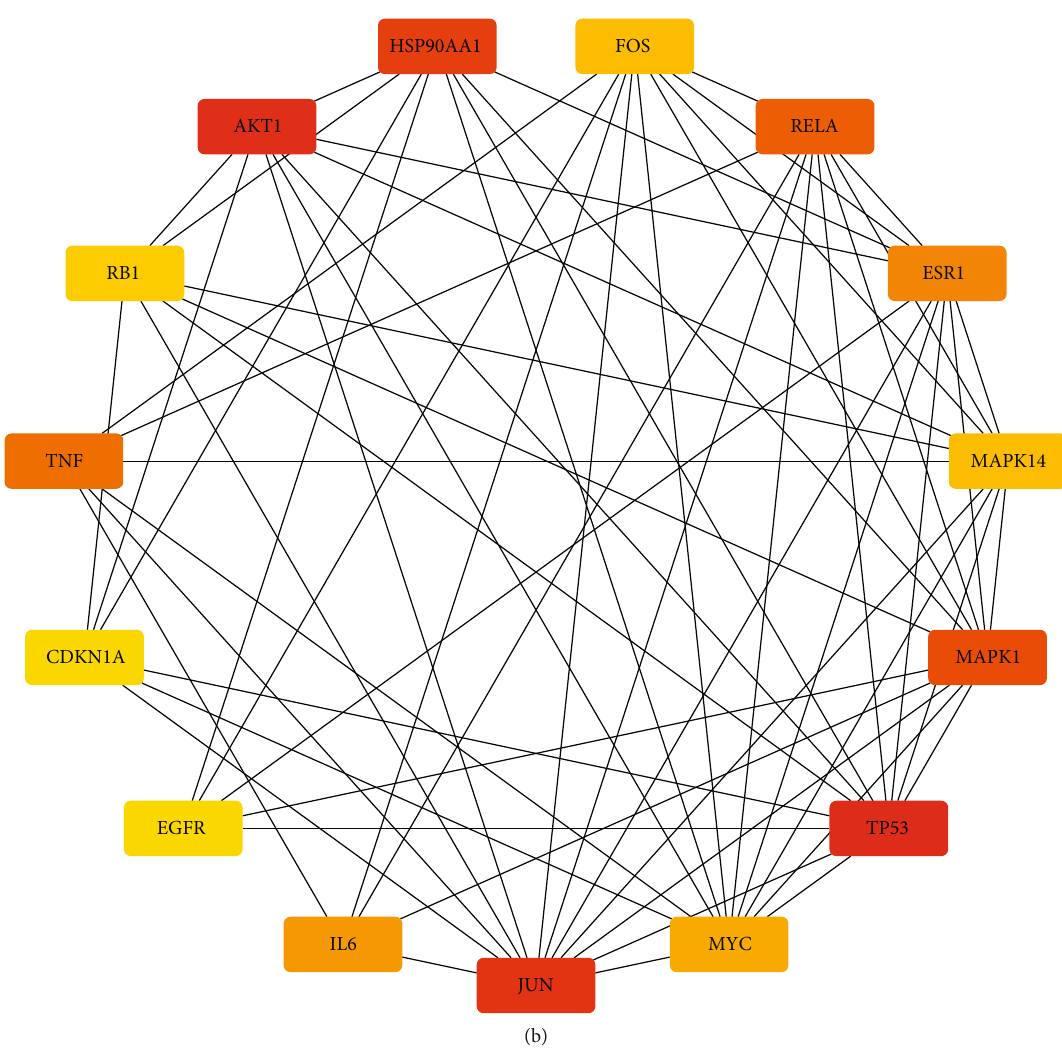
Figure 4: Protein-protein interaction (PPI) network based on the candidate target genes of Polygoni Cuspidati Rhizoma et Radix against acute liver failure. (a) PPI network of the candidate target genes. Each node represents the protein product of an associated target gene. The degree values of the proteins are represented by the node sizes. Colors indicate the connection sources. (b) The top 15 core target genes were identi fi ed based on the degree values. The protein with the darkest color has the highest degree value, indicating that it plays the most signi fi cant role in the regulation of the